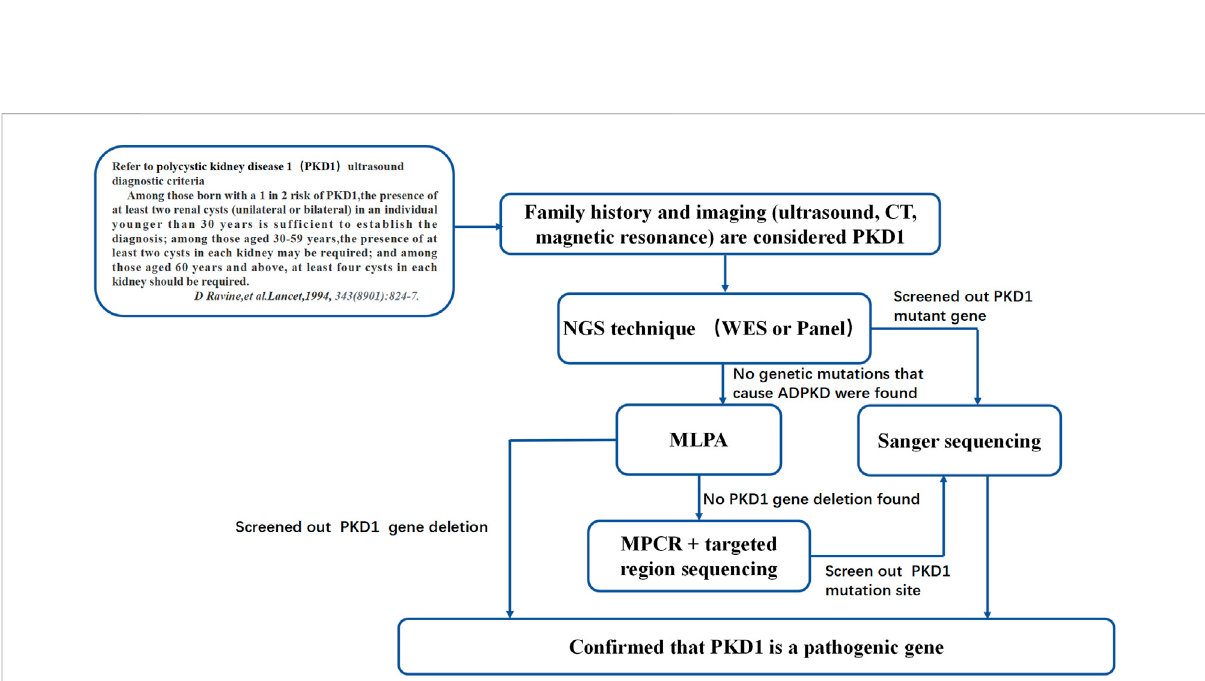
FIGURE 7 ADPKD genetic diagnosis fl owchart. This diagnosis fl owchart is suitable for patients who have been diagnosed with ADPKD through clinical diagnosis but have not been found to have pathogenic genes that cause ADPKD based on gene sequencing and